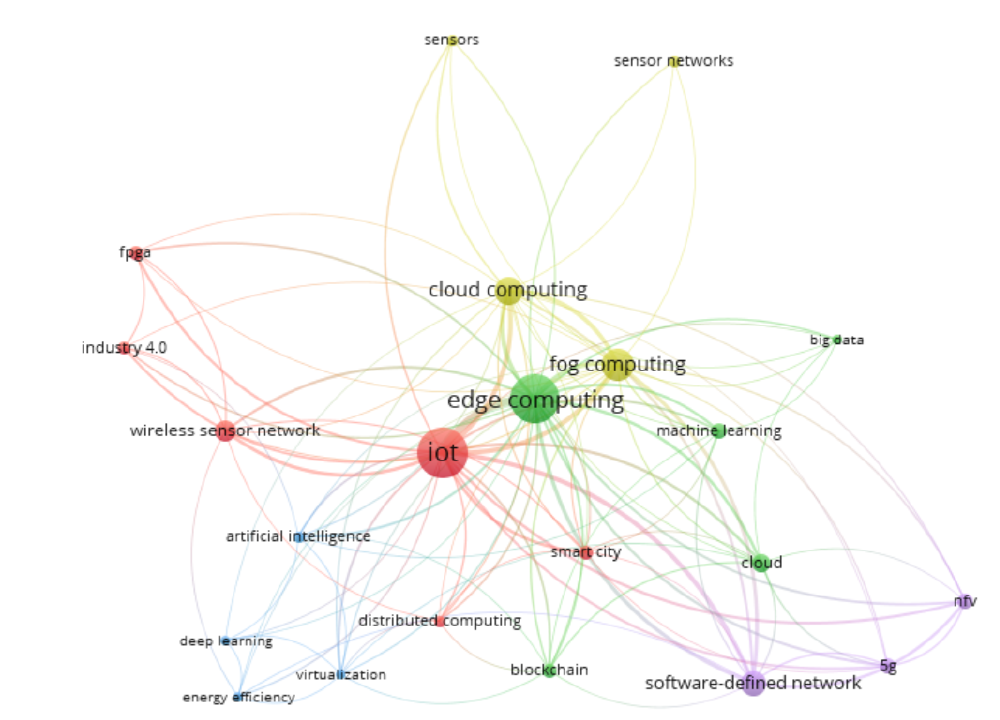
Figure 2. The co-occurrence network of the keywords of “edge computing” and “software sensor”- related articles in the Scopus database. As can be seen, the papers are clustered into four categories. Red shows the IoT, green the edge, yellow fog-, cloud computing and sensors, and blue shows the artificial-intelligent and deep-learning